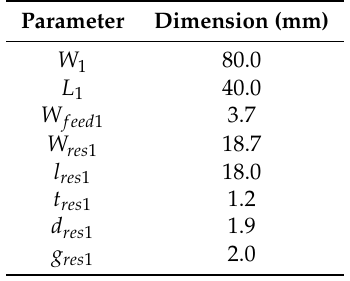
Table 1. Dimensions of the multi-stopband structure.